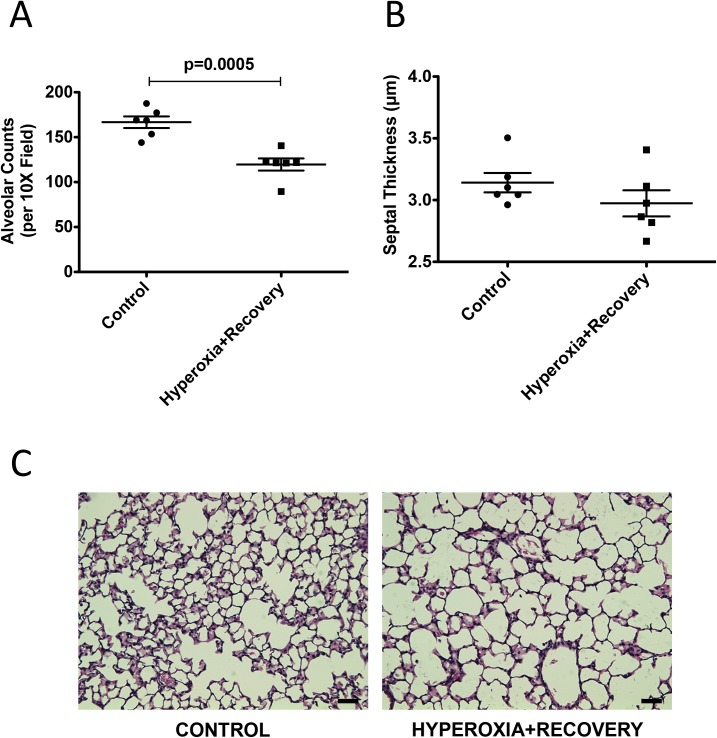
Neonatal hyperoxia exposure is associated with lower alveolar counts in 21d mice.Mice were exposed to hyperoxia or room air for 14d, followed by recovery in room air for an additional 7d (21d). (A) Alveolar counts and (B) septal thickness were measured using research-based digital image analysis software (n = 6 animals per group). (C) Representative H&E lung sections are shown for control 21d and hyperoxia + recovery 21d. Bar = 50 μm. Data are expressed as dot plots with each dot representing individual animals with means and SEM represented by horizontal lines. Results were analyzed using an unpaired t-test.